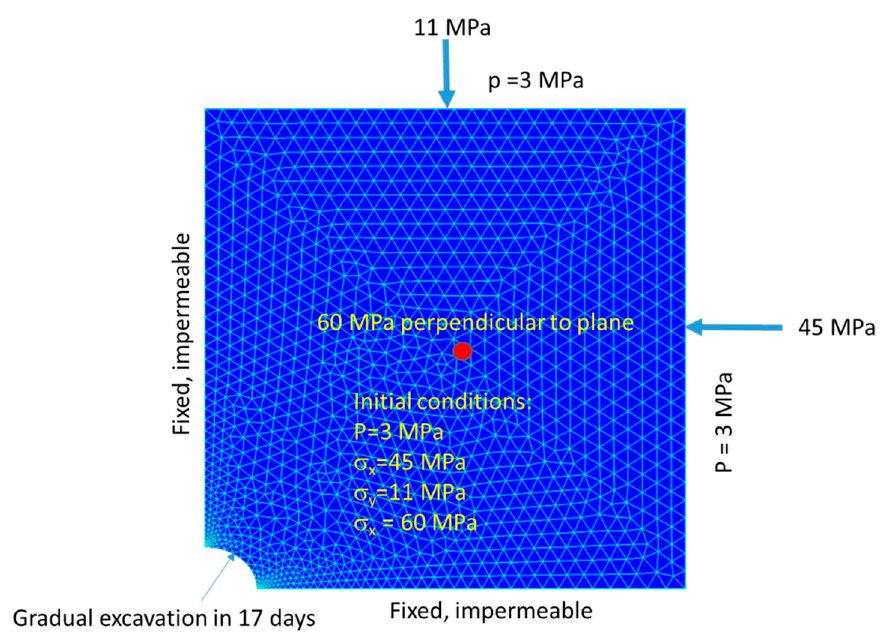
Figure 13. Finite element model, boundary and initial conditions for the TSX tunnel excavation.